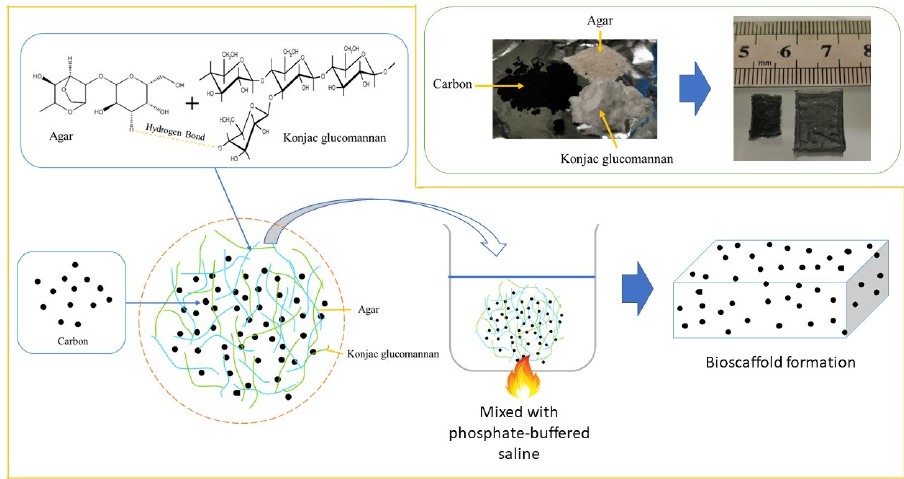
Figure 1. Schematic illustration of the bioscaffold formation.